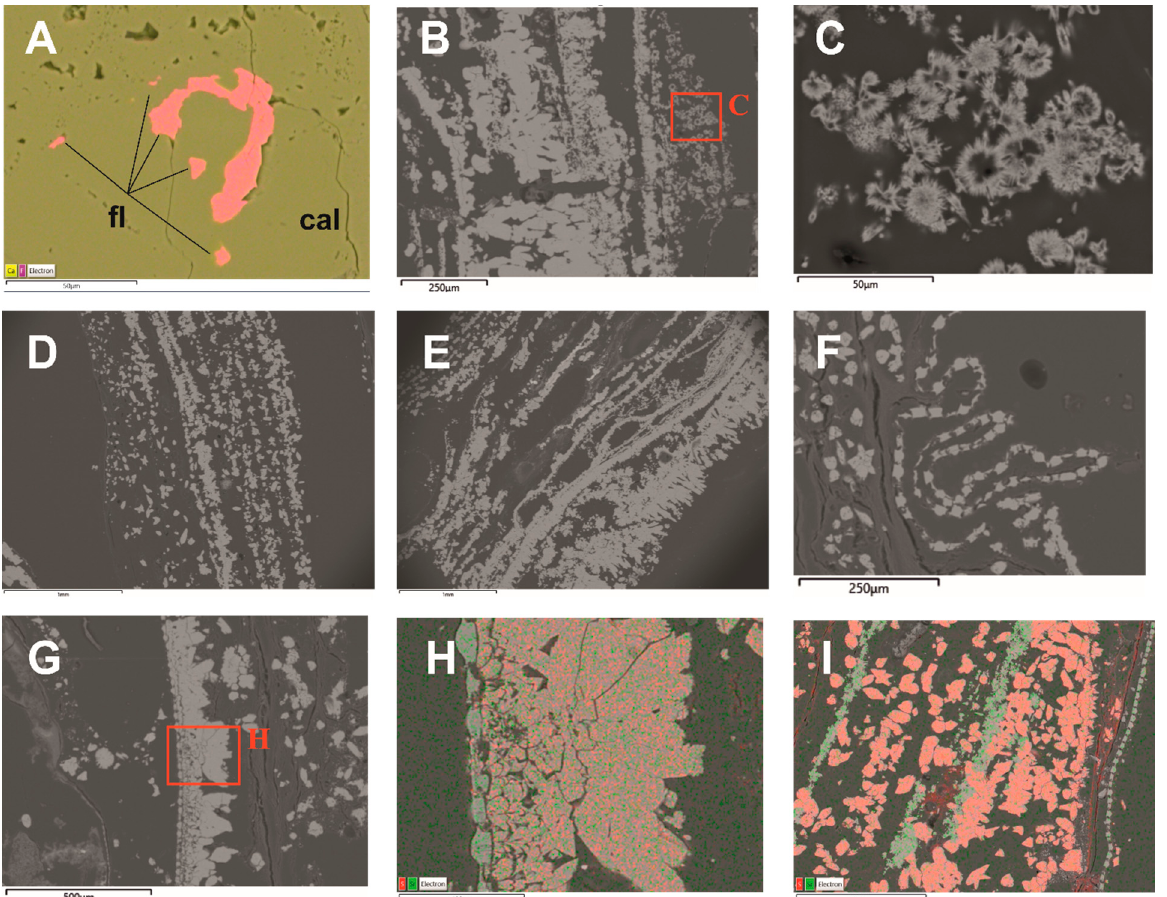
Figure 3. Evaluated XRD pattern of a characteristic sample. The dominant mineral phase is calcite (red columns), whereas aragonite is also present (blue columns).